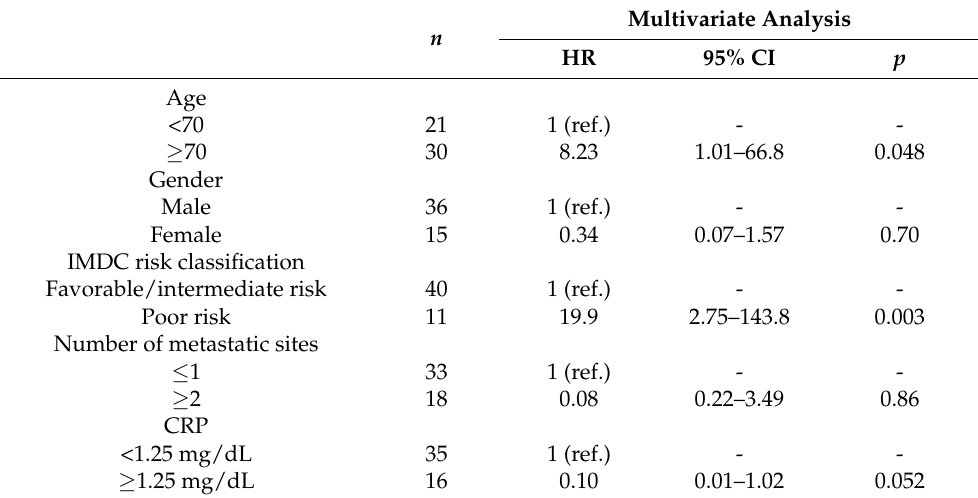
Table 3. Multivariate analysis of clinical parameters for the prediction of progression-free survival.